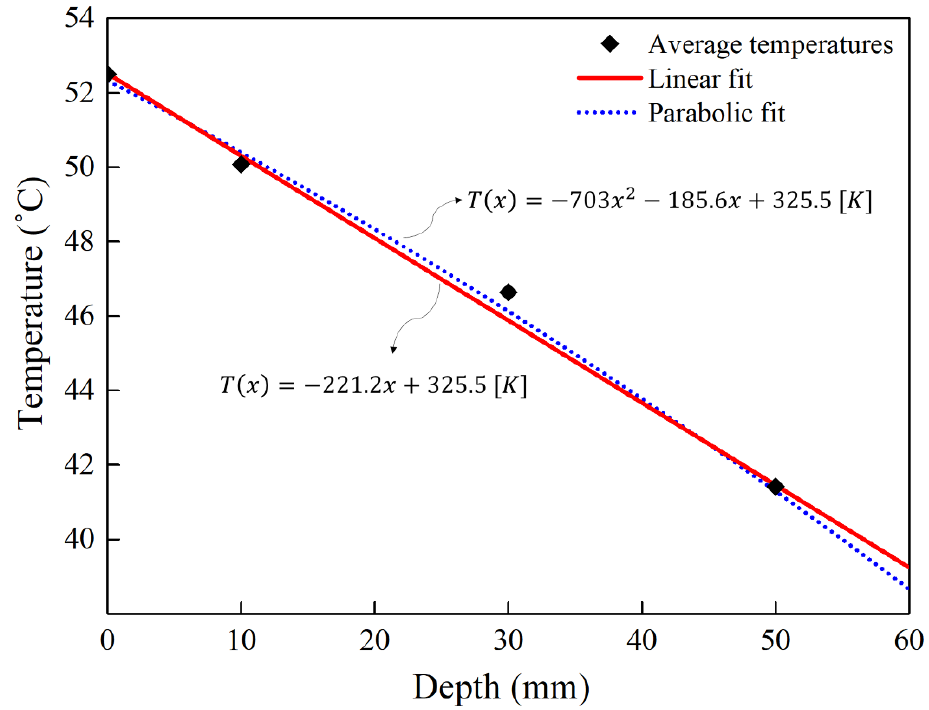
Figure 6. Average temperature profile from the measurement with linear and parabolic fit to the profile, where x is in meters and T ( x ) in Kelvin. (Single-column fit).